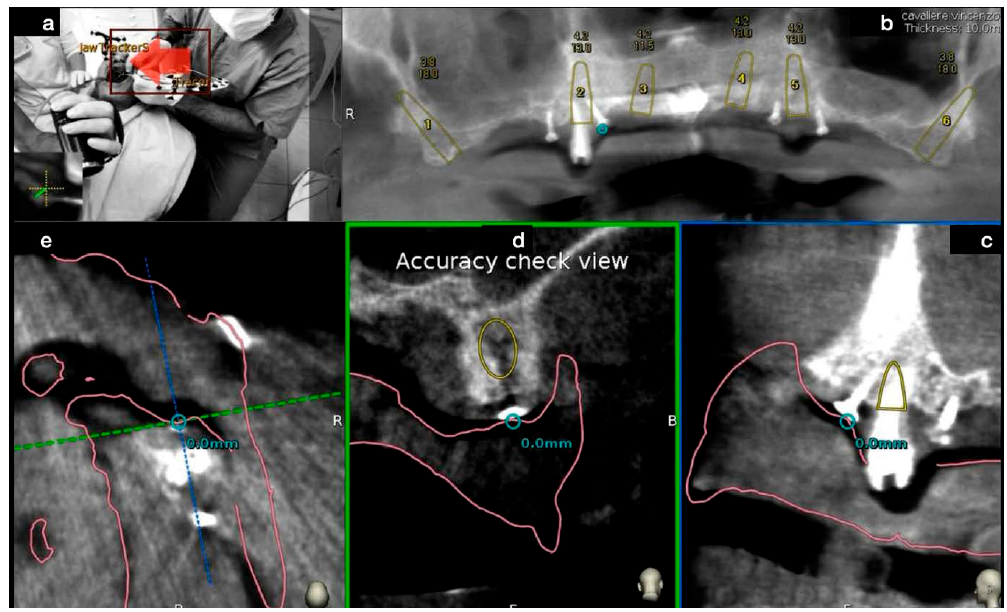
Figure 10. Before starting implant bed’s preparation the operator ( a ) performed an accuracy check of the tracing procedure to verify the congruency between the touched point and its radiological representation, for each available plane ( b – e ).